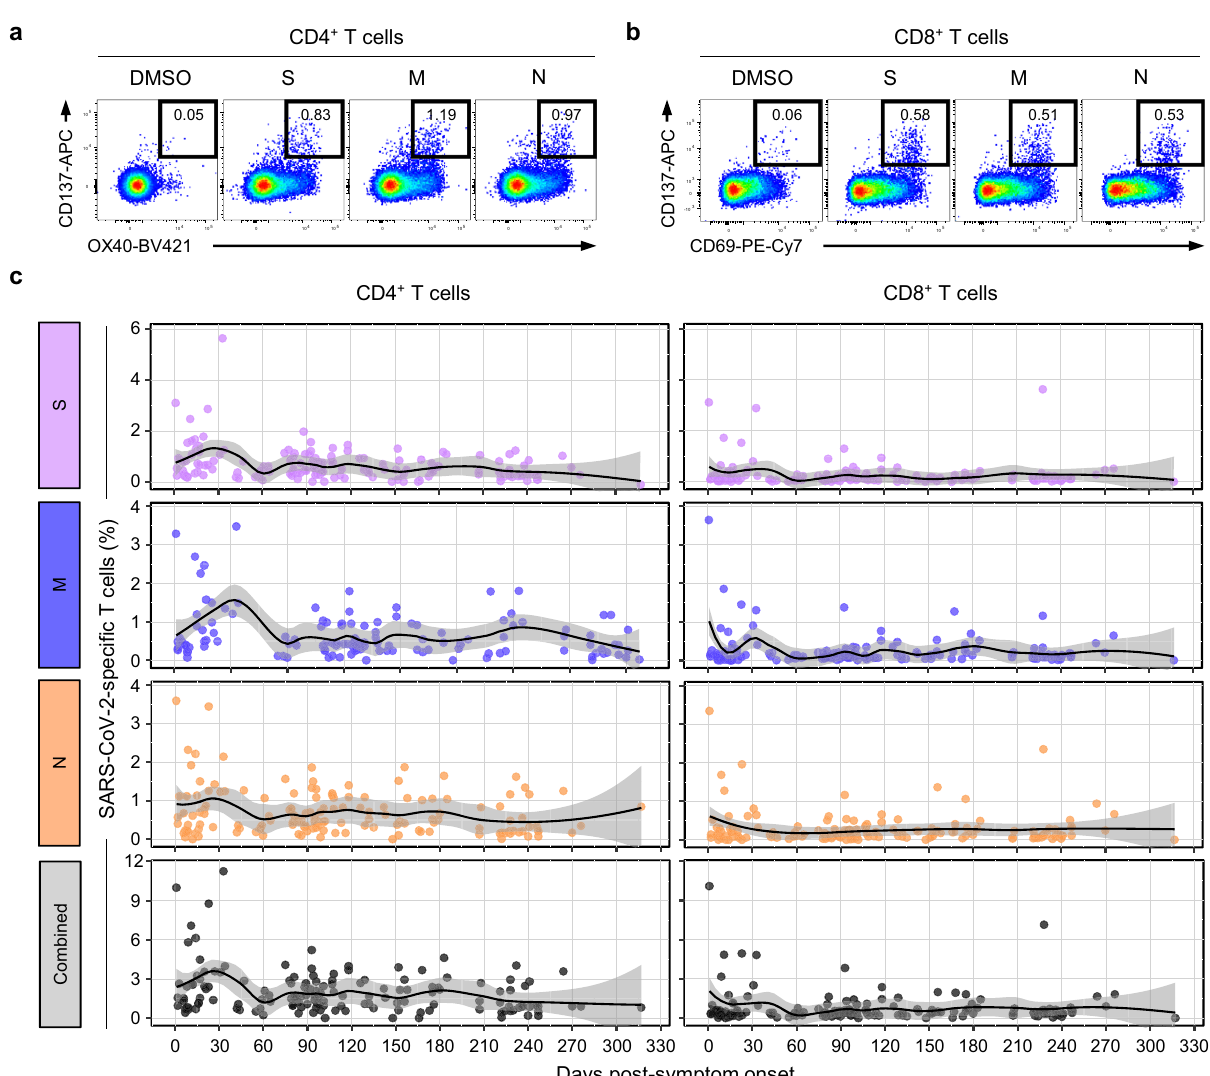
Fig. 2 Kinetics of SARS-CoV-2-speci fi c activation-induced marker (AIM) + T cells. PBMC samples ( n = 146) from individuals with SARS-CoV-2 infection ( n = 82) were stimulated with OLPs of S, M, or N (1 μ g/mL) for 24h. The frequency of AIM + (CD137 + OX40 + ) cells among CD4 + T cells and the frequency of AIM + (CD137 + CD69 + ) cells among CD8 + T cells were analyzed. Representative fl ow cytometry plots showing the frequency of AIM + cells among CD4 + ( a ) or CD8 + ( b ) T cells. c Scatter plots showing the relationship between DPSO and the frequency of AIM + cells among CD4 + (left) or CD8 + (right) T cells. The black is a LOESS smooth nonparametric function, and the gray shading represents the 95% con fi dence